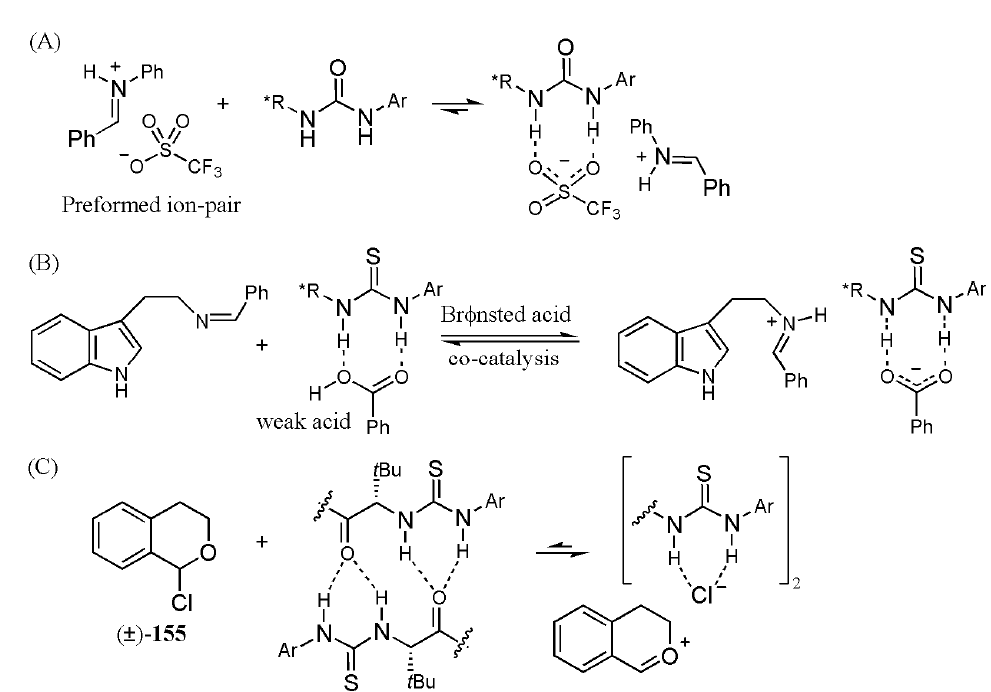
Figure 46. Activation modes in anion-binding catalysis by dual H-bond donor catalysts: ( A ) Binding involving pre-formed ion pairs; ( B ) Br φ nsted acid co-catalysis; ( C ) Anion abstraction catalysis [91].